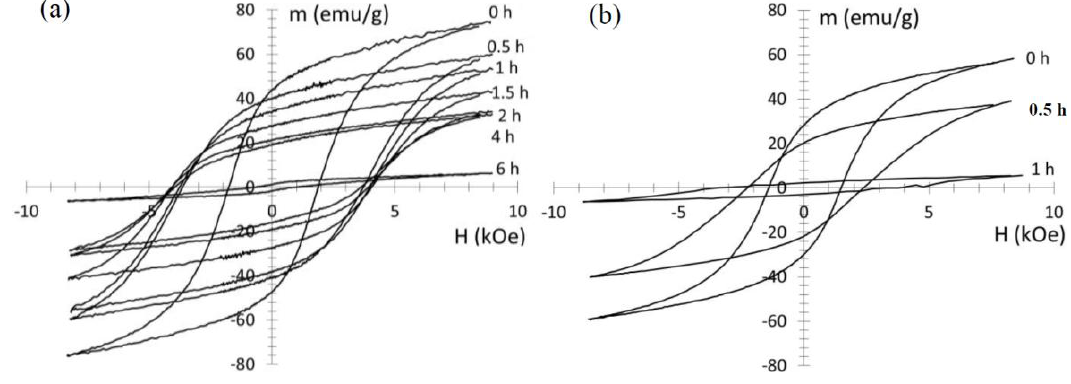
Figure 6. Relationship between coercivity and milling time and magnetization (at 8 kOe) and milling time for both the ( a ) ε milled (solid line), and ( b ) τ milled samples (dashed